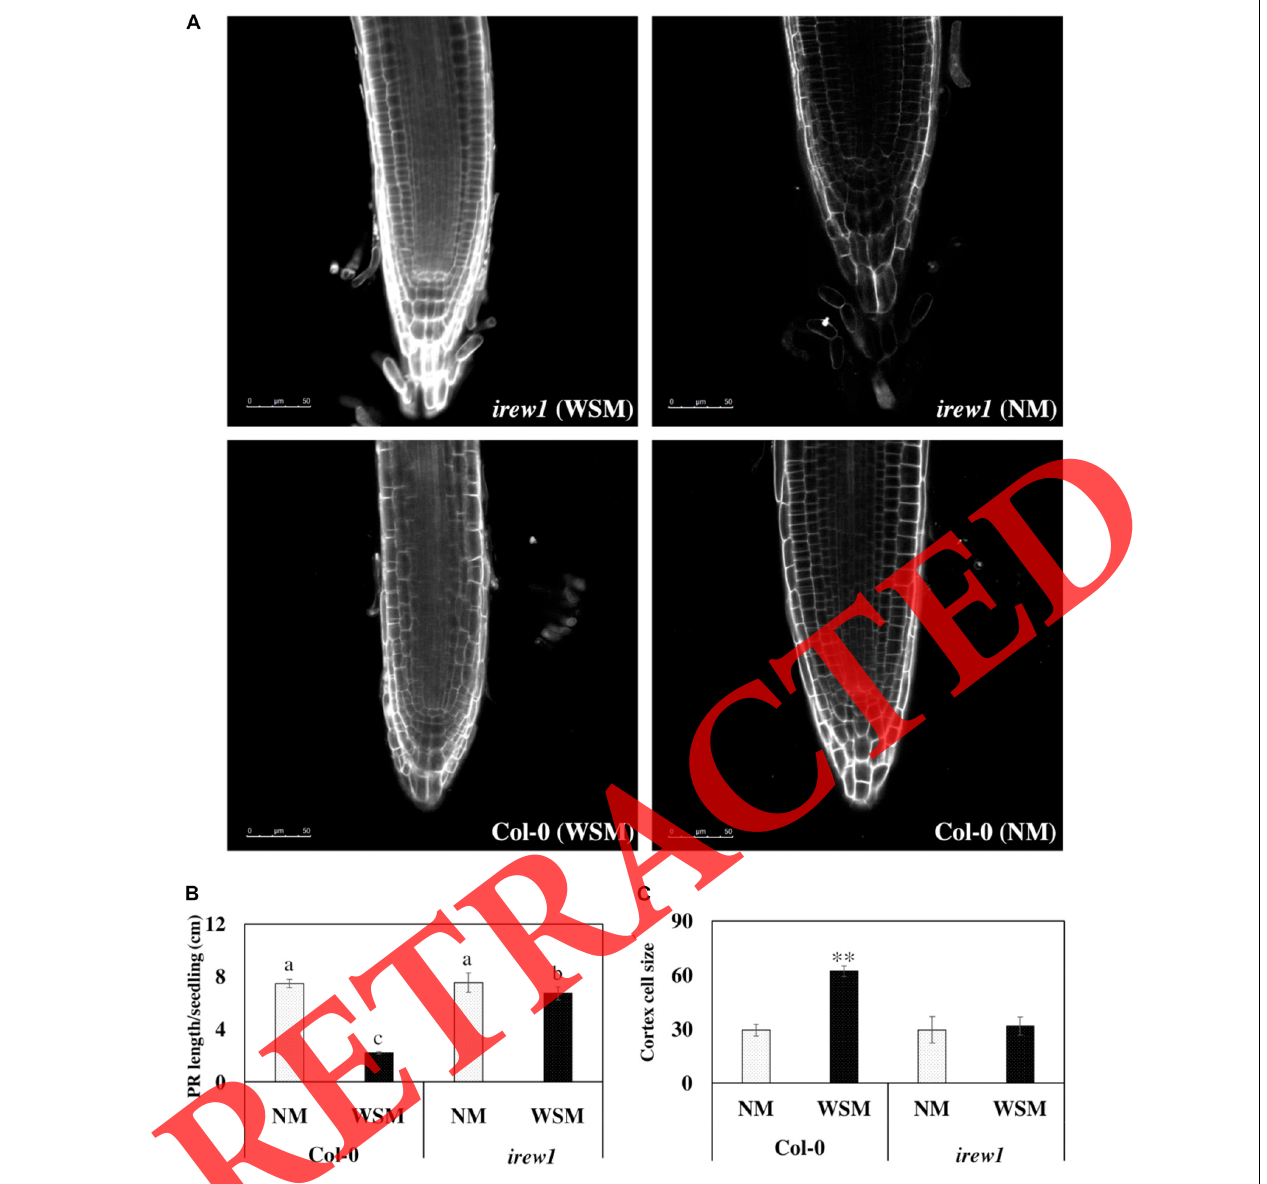
FIGURE 3 | Root tip morphology and differentially expressed root development-related genes of Col-0 and irew1 under WSM. (A) Root tips of 10 dag Col-0and irew1 seedlings grown on NM and WSM were stained with propidium iodide (PI) and observed by a confocal microscope. (B) Measurement of primary root (PR) length of Col-0 and irew1 grown on NM and WSM [four biological replicates; three independent experiments ( n = 12)]. Bars with different lowercase letters represent significant difference at P < 0.05, as determined by a Tukey’s post hoc test. (C) Cortex cell sizes of Col-0 and irew1 grown on NM and WSM [six biological replicates; three independent experiments ( n = 18)]. Bars with different lowercase letters represent significant difference at P < 0.05, as determined by a Tukey’s post hoc test. WSM represents seedlings grown on a water stress media (WSM); NM represents seedlings grown on the normal media